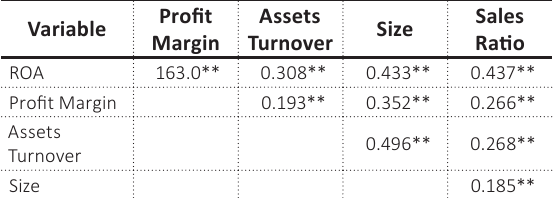
Table 3. Pearson correlation matrix